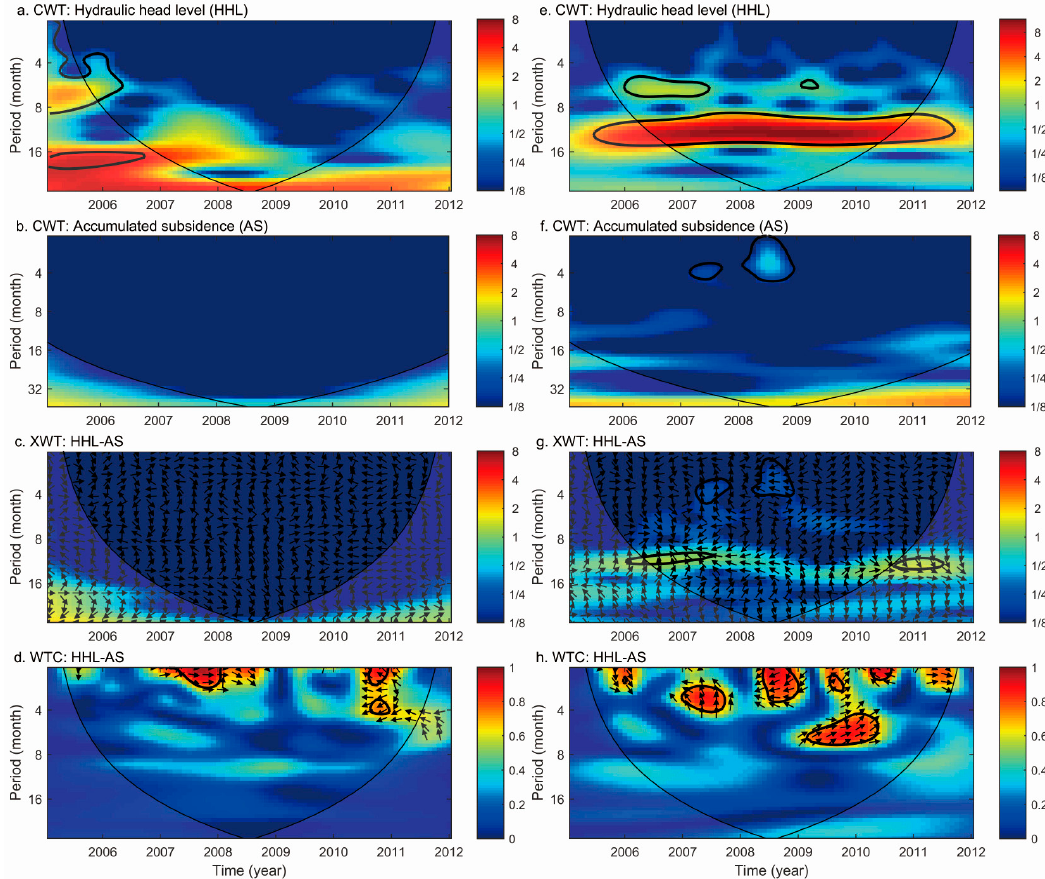
Figure 9. ( a ) Wavelet power spectrum (Morlet wavelet) of the HHL at Well 1; ( b ) wavelet power spectrum (Morlet wavelet) of the AS at Well 1; ( c ) the cross-wavelet power between the HHL and AS at Well 1; and ( d ) the wavelet coherency and phase between HHL and AS at Well 1. ( e – h ) The same as ( a – d ) but for Well 2. Arrows indicate the phase difference between the HHL and AS. The thick black contour is the 5% significance level using the red noise model, while the thin black line indicates the cone of influence (COI).